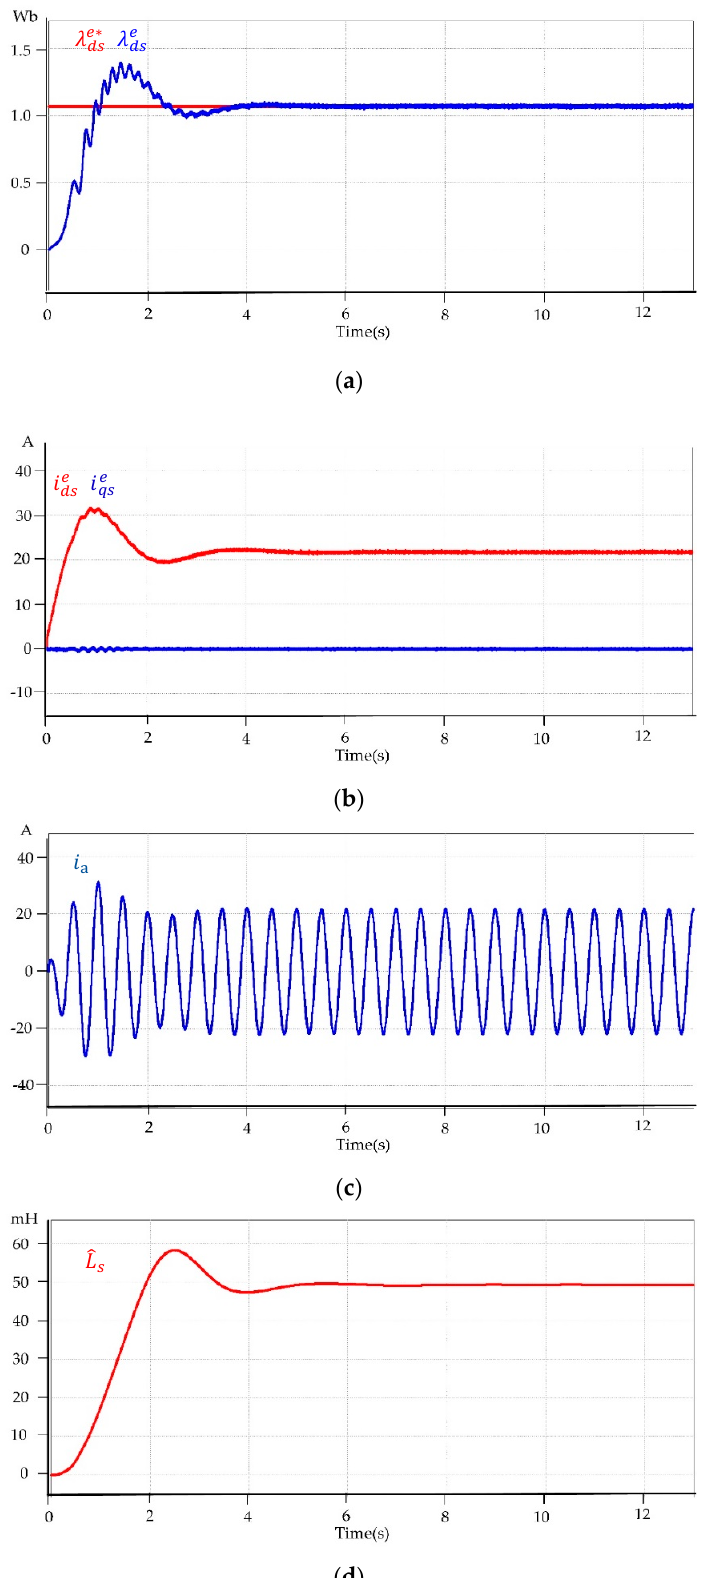
Figure 7. Simulation results for motor (18.5 kW/415 V); ( a ) reference and estimated stator flux, ( b ) dq -axis reference and measured currents in a rotating reference frame, ( c ) a-phase current, ( d ) identified stator inductance.